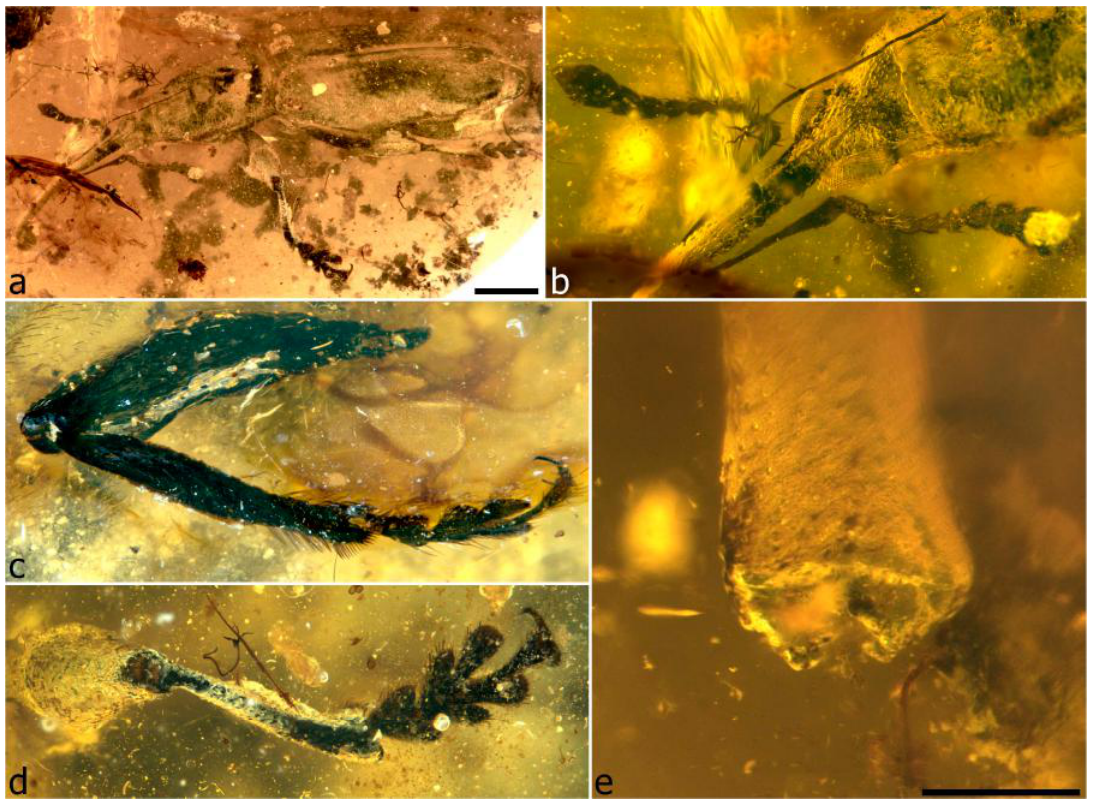
Figure 41. Petalotarsus sp. Habitus, left lateral ( a ); head and antennae, dorsal ( b ); right hindleg ( c ); left foreleg, dorsal ( d ); apex of rostrum and mandibles, dorsal ( e ). Scale bars: 1.0 mm (a); 0.2 mm (e). Genus Opeatorhynchus Clarke & Oberprieler, gen. n.